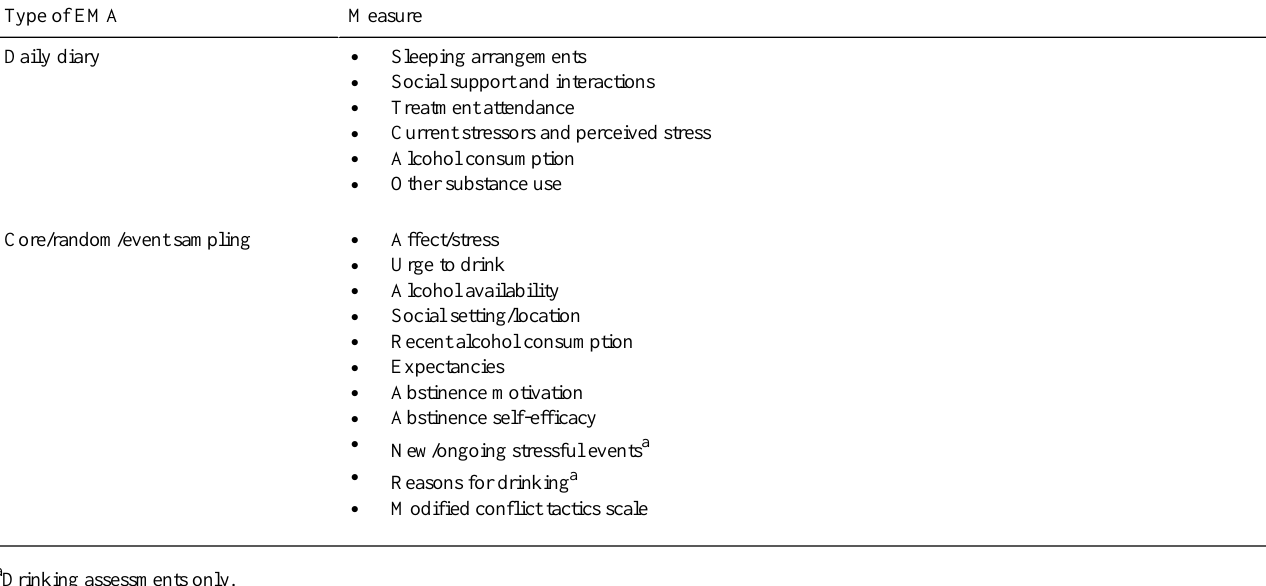
Table 3. Ecological momentary assessment (EMA) measures.